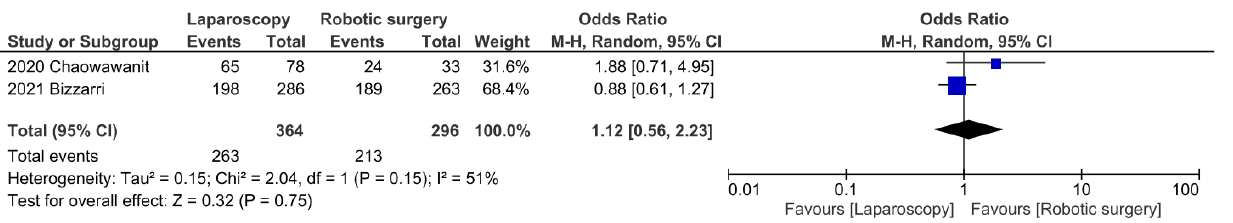
Figure 3. Forest plot of individual and pooled odds ratios, with 95% confidence interval (CI), for overall detection, comparing laparoscopy and robotic surgery for SLN biopsy in EC women.